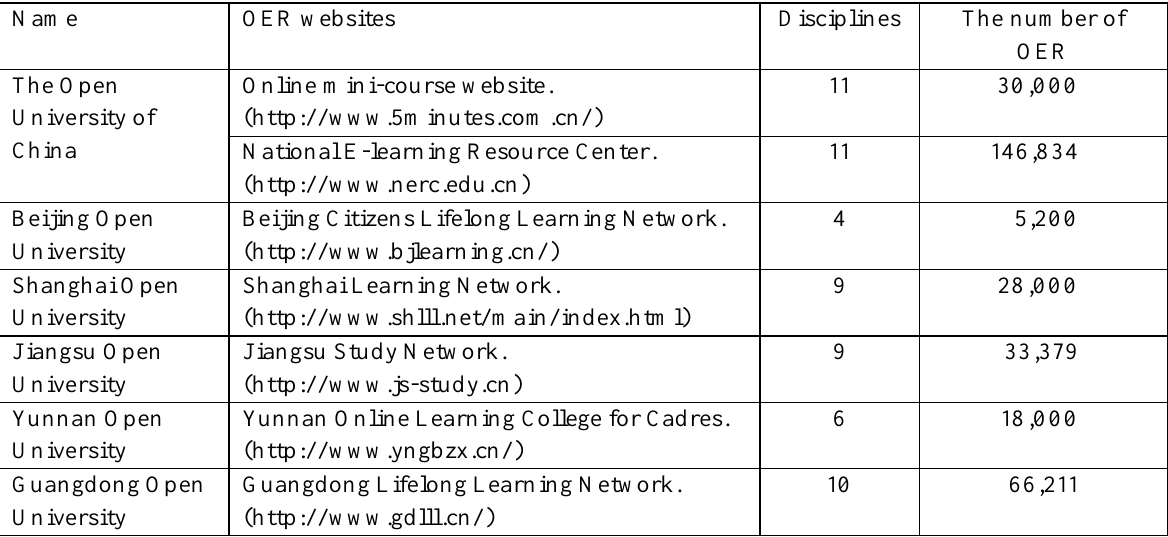
The Website and Number of OER in Six Open